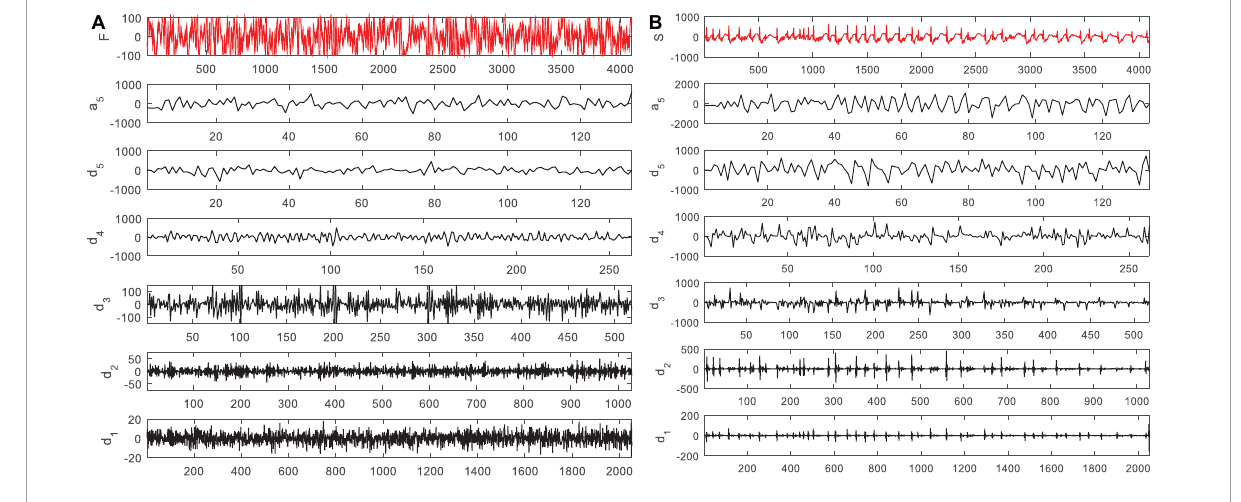
figure, S represents the primary EEG signal. A i indicates low frequency data in i -th level and D i indicates high frequency data in this